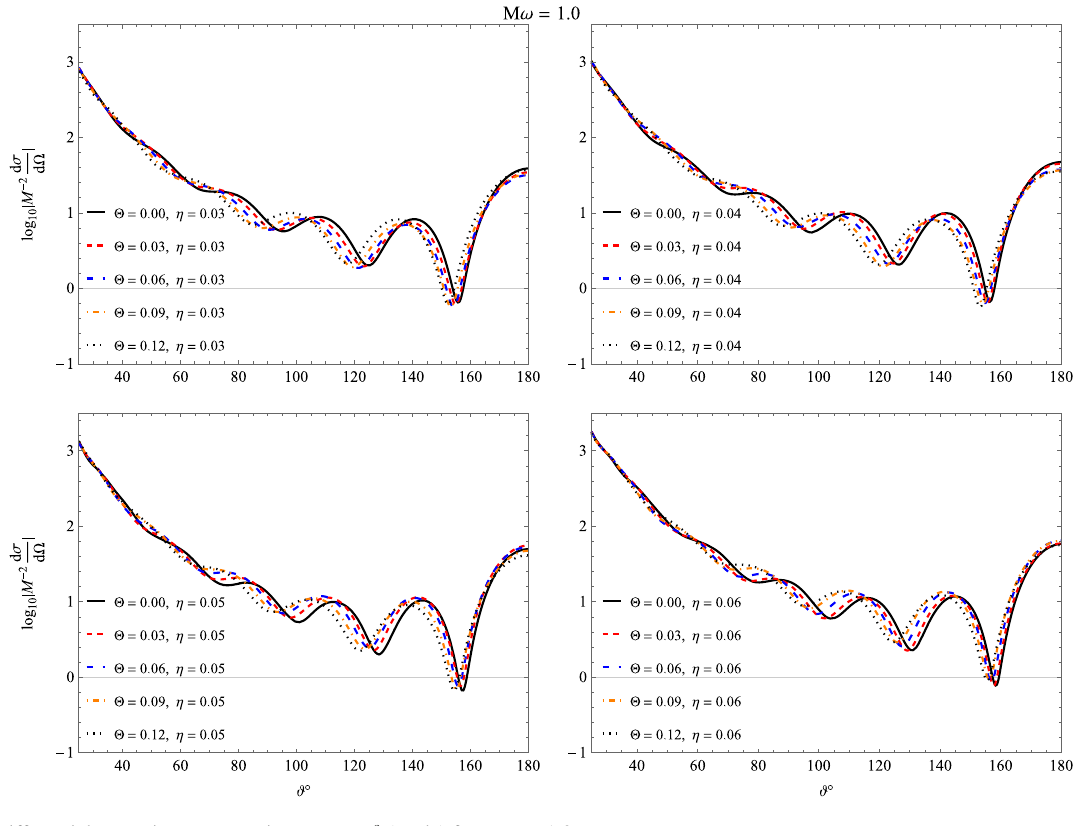
Fig. 7 Differential scattering cross section versus ϑ o (angle) for M ω = 1 . 0